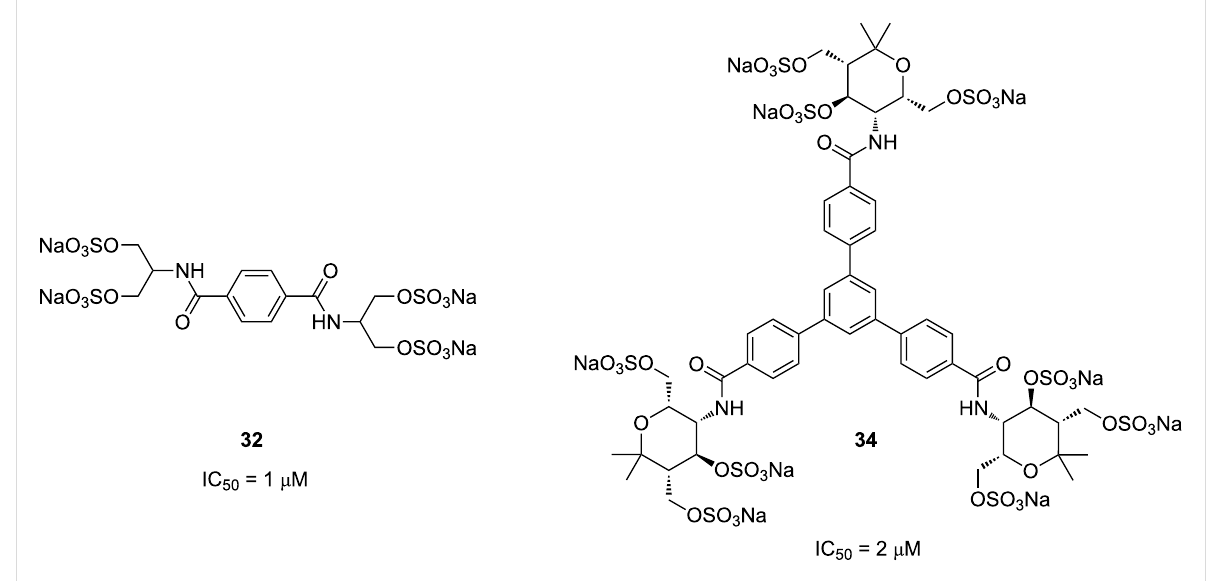
Figure 1: Structures of O -sulfated divalent amide 32 and trivalent amide 34 and their respective IC 50 values for L-selectin as determined by SPR.